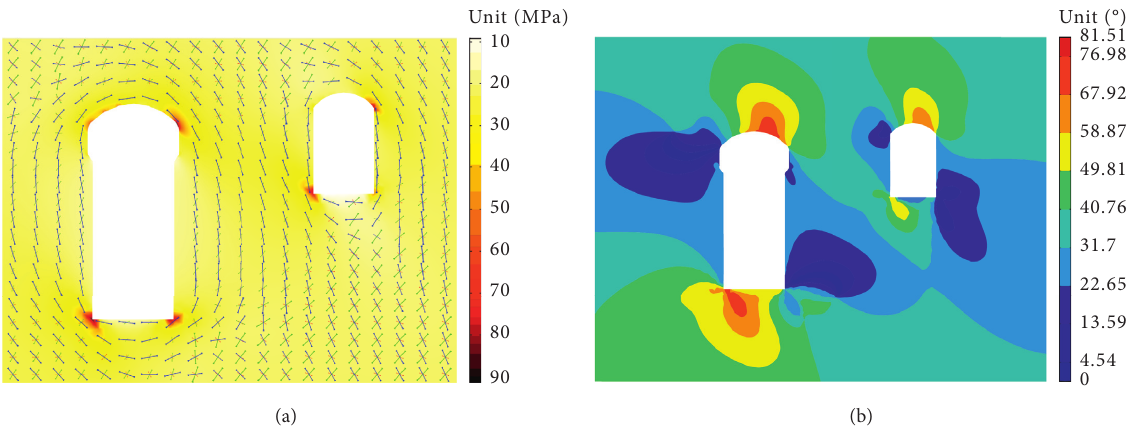
Figure 16: (a) The maximum principal stress distribution along the cross section of underground powerhouse. (b) The angle of β dis- tribution along the cross section of underground powerhouse.